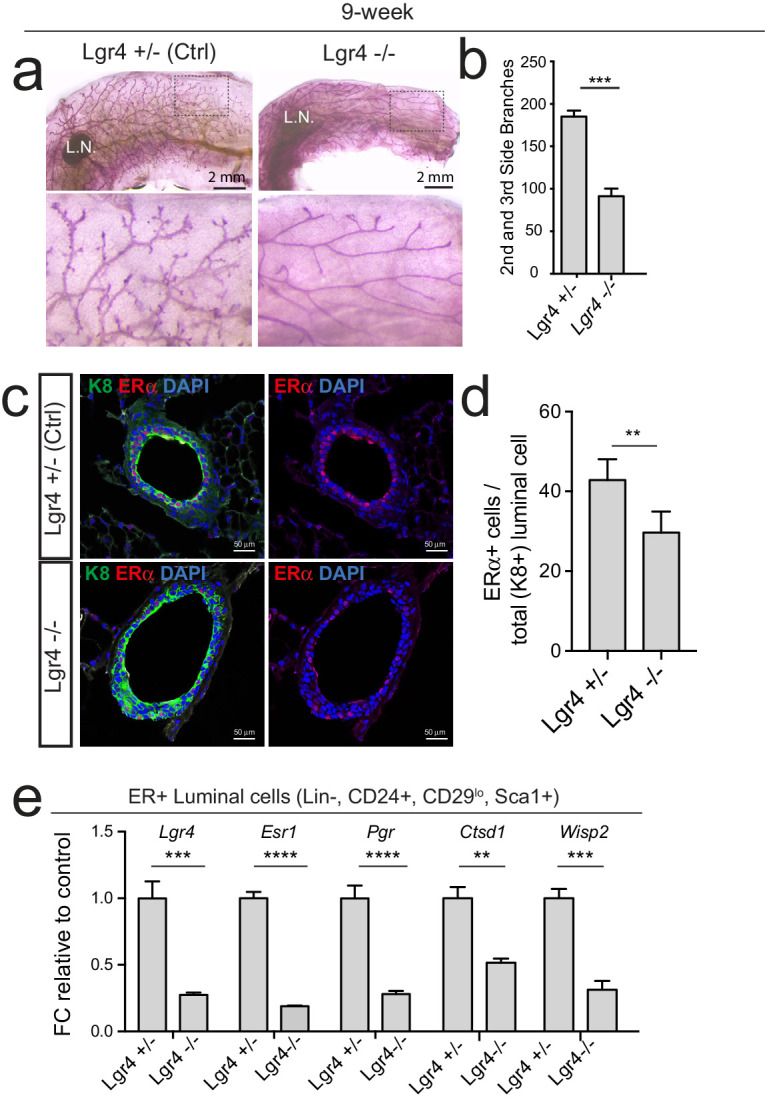
Loss of Lgr4 reduces Esr1 expression and ERα signaling activities.(a) Lgr4-/- mammary glands display reduced side branches. (b) Quantification of side branches was performed in designated area. More than six views were used for quantification. (c) Immunostaining of ERα in 8-week-old virgin control and Lgr4-/- mammary gland. More than six views were used for quantification. Scale bar, 50 μm. (d) Quantification of the proportion of ERα+ luminal cell among all luminal cells. (e) qPCR analysis of ER+ luminal cells (Lin-,CD24+,CD29lo,Sca1+) from mammary gland 1) confirming Lgr4 deficiency in Lgr4-/- mammary gland; 2) indicating that Esr1 expression is significantly decreased in Lgr4-/- mammary gland, and 3) reduced ERα targets Pgr, Ctsd1 and Wisp2. n = 3 mice. L.N. Lymph node. (d, e) Data are presented as mean ± s.e.m. Student’s t test: ****p<0.0001, ***p<0.001, **p<0.01, *p<0.05. ns, not significant.